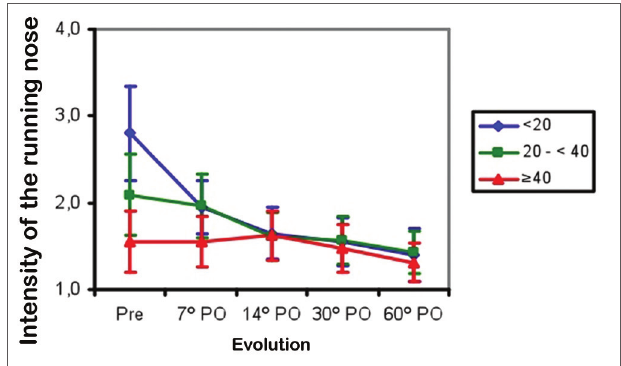
Figure 3. Mean coryza score in three age groups (years) in the preo- perative (Pre) and postoperative (PO)